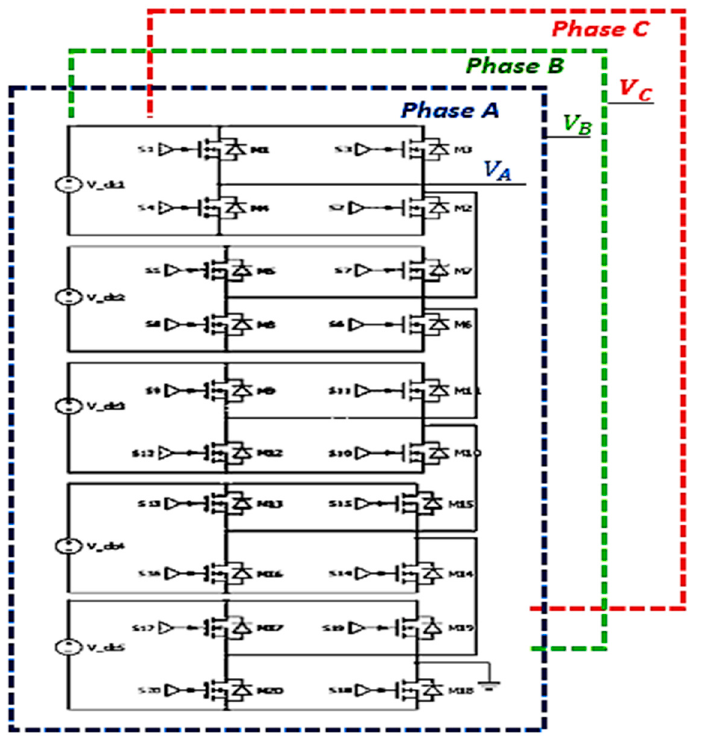
Figure 1. Eleven-level three-phase cascaded H-bridge multilevel inverter